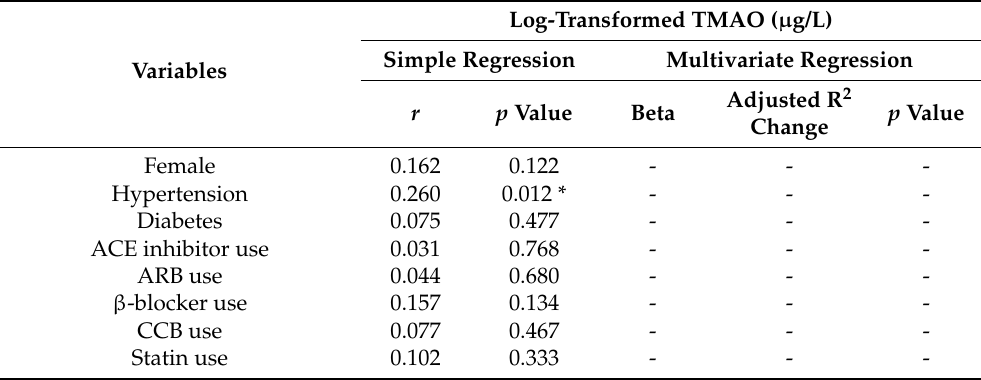
Table 3. Correction between log-transformed trimethylamine N-oxide level and clinical